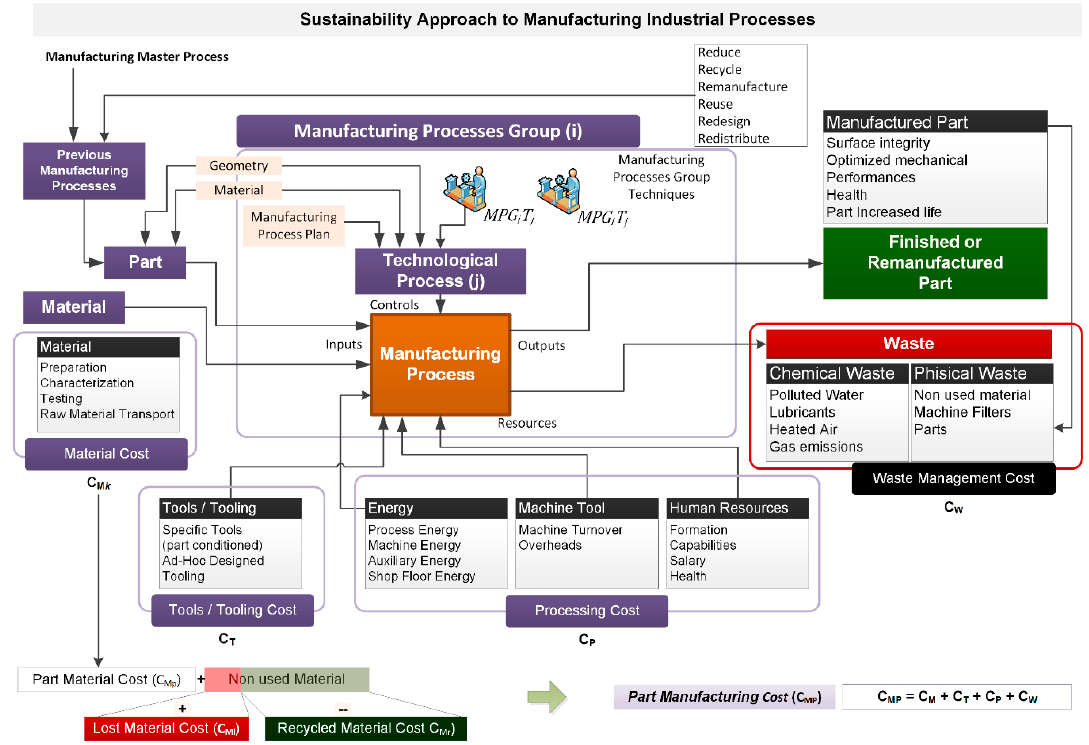
Figure 2. Activity model of a generic industrial manufacturing processes.